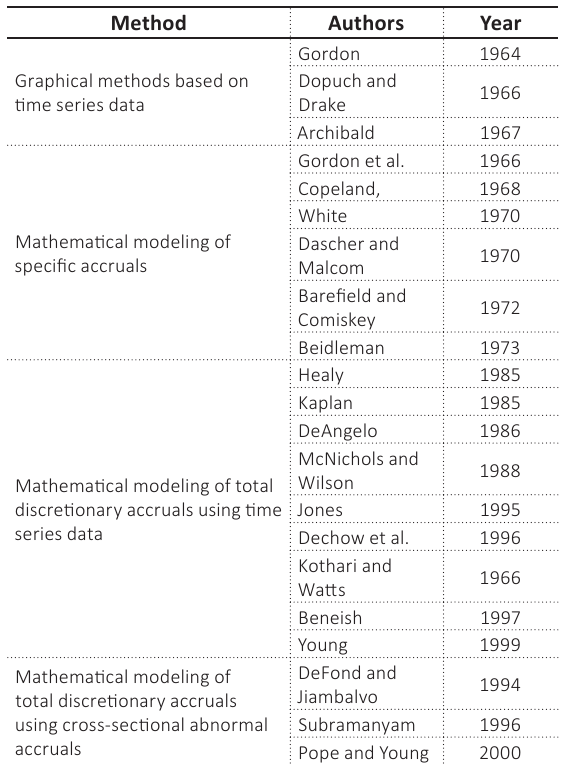
Table 1. The most frequently used calculation Table 2. Characteristics of the